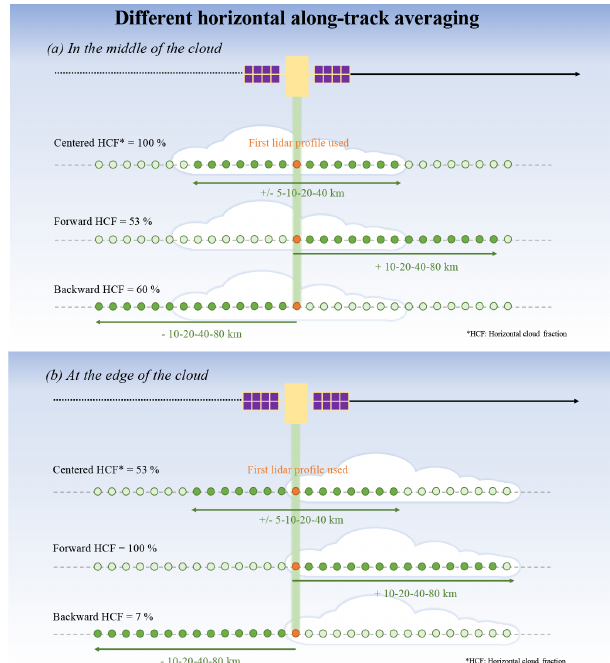
Figure 3. Illustration of the horizontal along-track averaging that is used by the DA to compute the horizontal cloud fraction (HCF): (a) the lidar beam is in the middle of the cloud and (b) the lidar beam is at the edge of the cloud. The dark-green circles correspond to the profiles used in the different horizontal averaging scenarios (centered, forward or